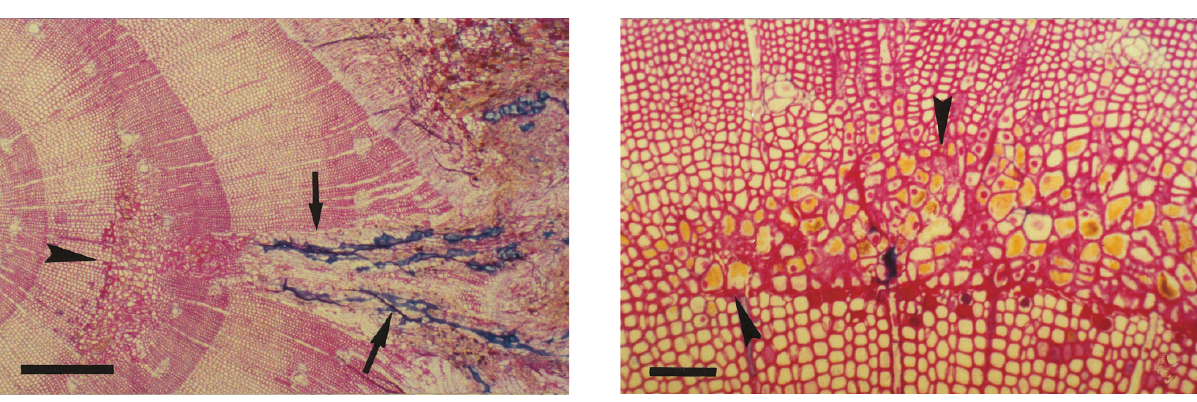
Fig. 9. Cross-section of the 2nd year growth ring of an Aleppo pine twig showing abnormal xylem formed by parenchymal cells with thickened and ligni fi ed walls (arrow heads). Bar=100 μ m (fuchsin-Astra blue).